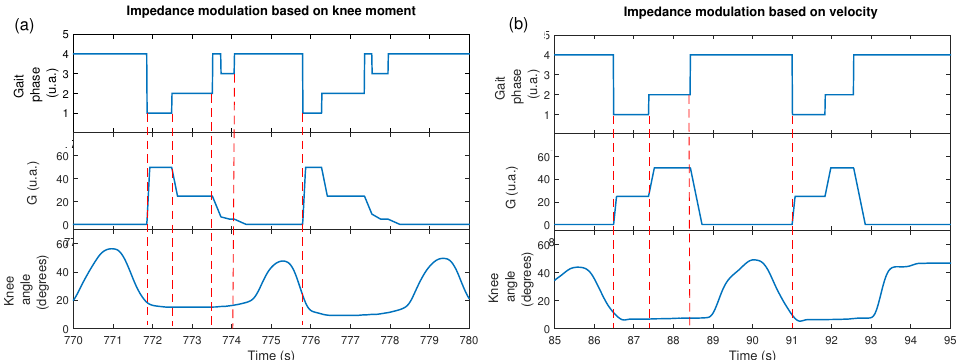
Figure 10. Footswitch signal, gain variation and knee angle during gait with impedance modulation. ( a ) modulation obtained from the pattern P 1 based on normal velocity; ( b ) modulation obtained from the pattern P 2 based on the knee moment.